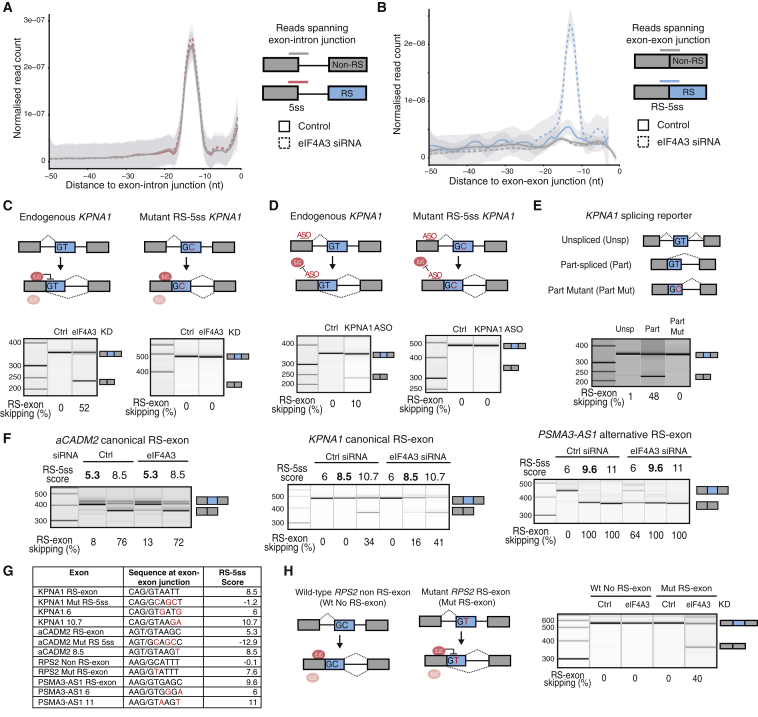
Skipping of Annotated RS-Exons upon EJC KD Results from Recursive Splicing(A) The count of PRPF8 iCLIP reads that identify crosslinks at each nucleotide upstream of exon-intron junctions is normalized by the total number of evaluated junctions (RS = 4,631; non-RS = 130,410) and the total number of crosslinks in each experiment. HeLa cells treated with either control or eIF4A3 siRNAs were used for iCLIP (n = 4 per group, 2 independent experiments). Reads upstream of RS-exons and non RS-exons are plotted in orange and gray, respectively. The data were smoothed using locally weighted scatterplot smoothing (LOESS). Shaded regions represent 95% confidence intervals.(B) Density plot as in (A), but assessing PRPF8 iCLIP upstream of exon-exon junctions. Crosslinks upstream of RS-exons or non RS-exons are plotted in blue or gray, respectively.(C) KPNA1 unspliced reporter with a mutant RS-5ss was stably integrated into HeLa cells, and the splicing pattern of endogenous or mutant RS-exon was analyzed by RT-PCR after eIF4A3 KD.(D) Same analysis as in (C), after transfecting cells with an antisense oligonucleotide complementary to the EJC deposition site.(E) RT-PCR analysis of wild-type and mutant unspliced and part-spliced reporters derived from the KPNA1 gene after their transient transfection into HeLa cells.(F) RT-PCR analysis of RS-exon splicing pattern after transient transfection of wild-type or mutant aCADM2, KPNA1, and PSMA3-AS1 reporters into HeLa cells treated with control or eIF4A3 siRNAs. The original RS-5ss score is indicated in bold, and the scores after mutation are in regular font.(G) Nucleotide sequences at the exon-exon junctions and their associated RS-5ss scores for the splicing reporters used in (C), (F), and (H). The nucleotides before and after the slash sign correspond to the last 3 nt of the preceding exon and the first 6 nt of the exon under study. Mutations are indicated in red.(H) Wild-type and mutant splicing reporters derived from RPS2 gene were transiently transfected into HeLa cells, and their splicing pattern was analyzed by RT-PCR after control or eIF4A3 KD.Results shown in (C)–(F) and (H) derive from a minimum of 3 independent replicates.